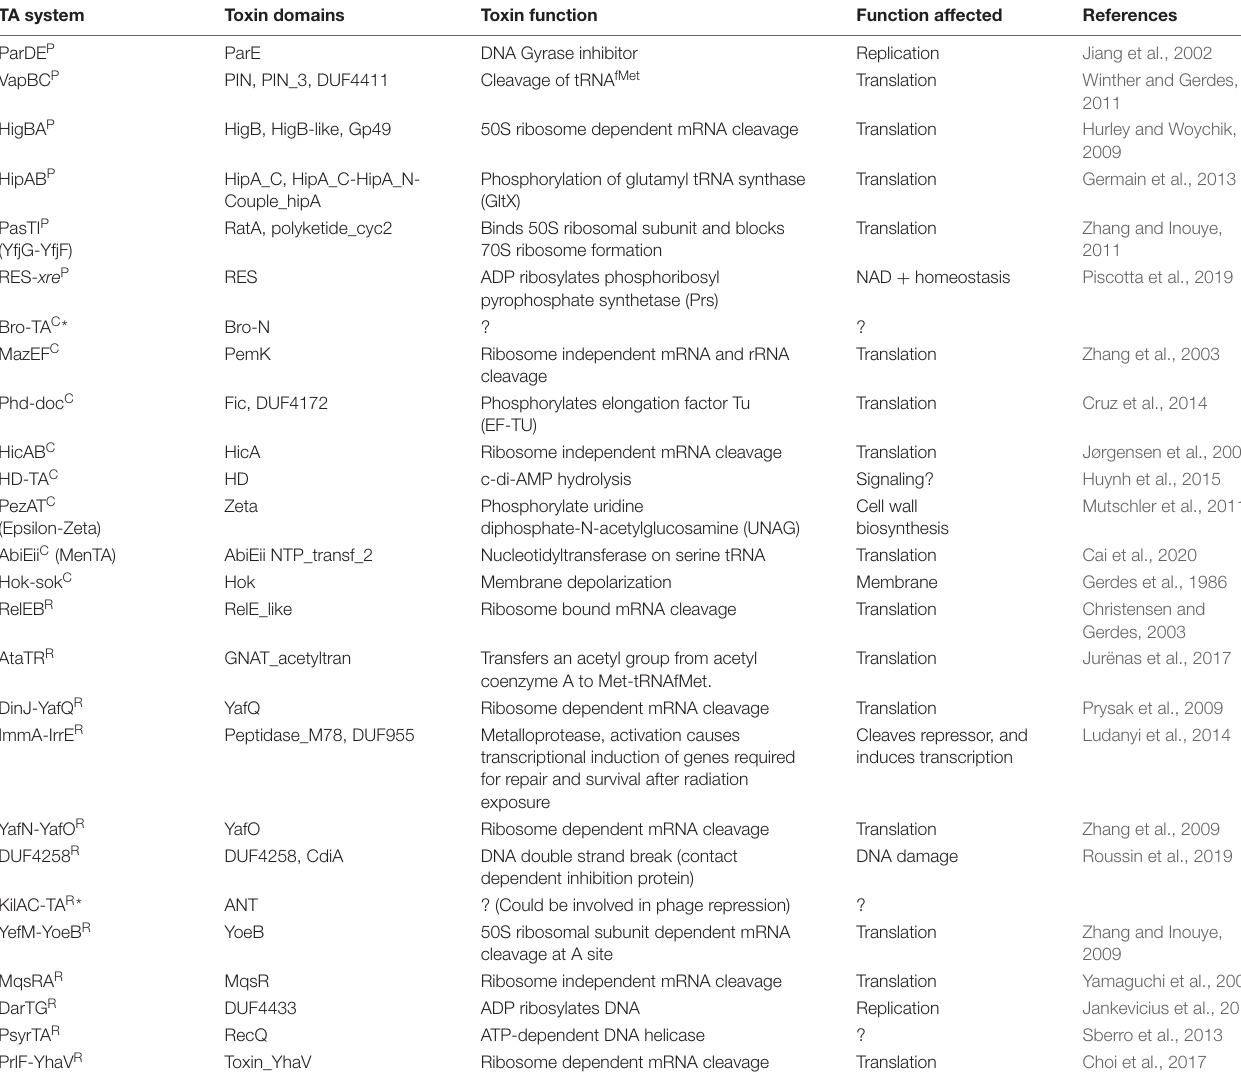
TABLE 1 | Toxin-antitoxin systems predicted in P. syringae , toxin function and physiological